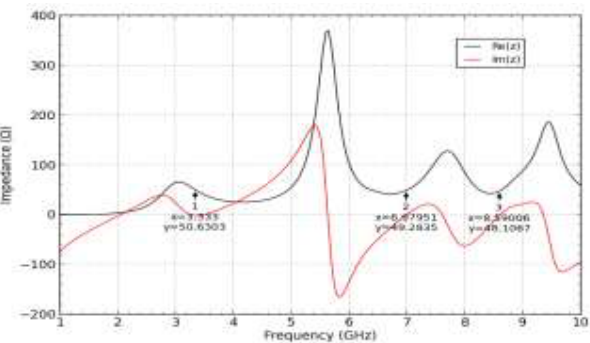
Figure 10: Simulated impedance versus frequency graph of the proposed antenna